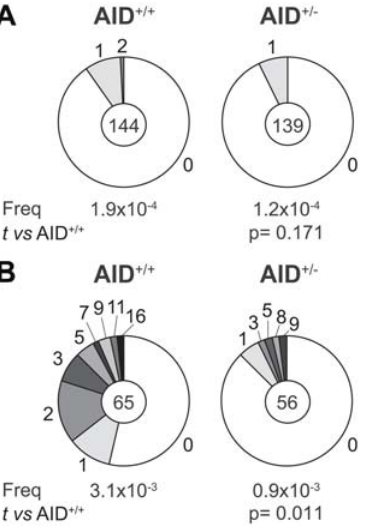
Figure 2. AID is haploinsufficient for SHM. (A) S m mutation frequency in AID + / + and AID + / 2 activated B cells. The S m mutation frequency was quantified in sorted CFSE-labelled spleen B cells that had undergone 5 or more divisions after 96h of LPS and IL4 stimulation. Segment sizes in the pie charts are proportional to the number of S m sequences carrying the number of mutations indicated in the periphery of the charts. The total number of independent sequences analyzed is indicated in the center of each chart. The calculated mutation frequency per base pair is indicated underneath. Statistical significance was determined by a two-tailed Student’s t test comparing the frequency found in AID + / + and AID + / 2 B cells. P values are indicated. (B) SHM analyzed in the intronic region 3 9 of JH4 of germinal center B cells from AID + / + and AID + / 2 mice. Segment sizes in the pie charts are proportional to the number of mutations found in the intronic region 3 9 of JH4 of Fas + GL7 + sorted B cells from Peyer’s patches of aged-matched AID + / + and AID + / 2 mice. The total number of independent sequences analyzed is indicated in the center of each chart. The calculated mutation frequency per base pair is indicated underneath. Statistical significance was determined by a two-tailed Student’s t test comparing the frequency of mutations found in AID + / + and AID + / 2 mice. P values are indicated.